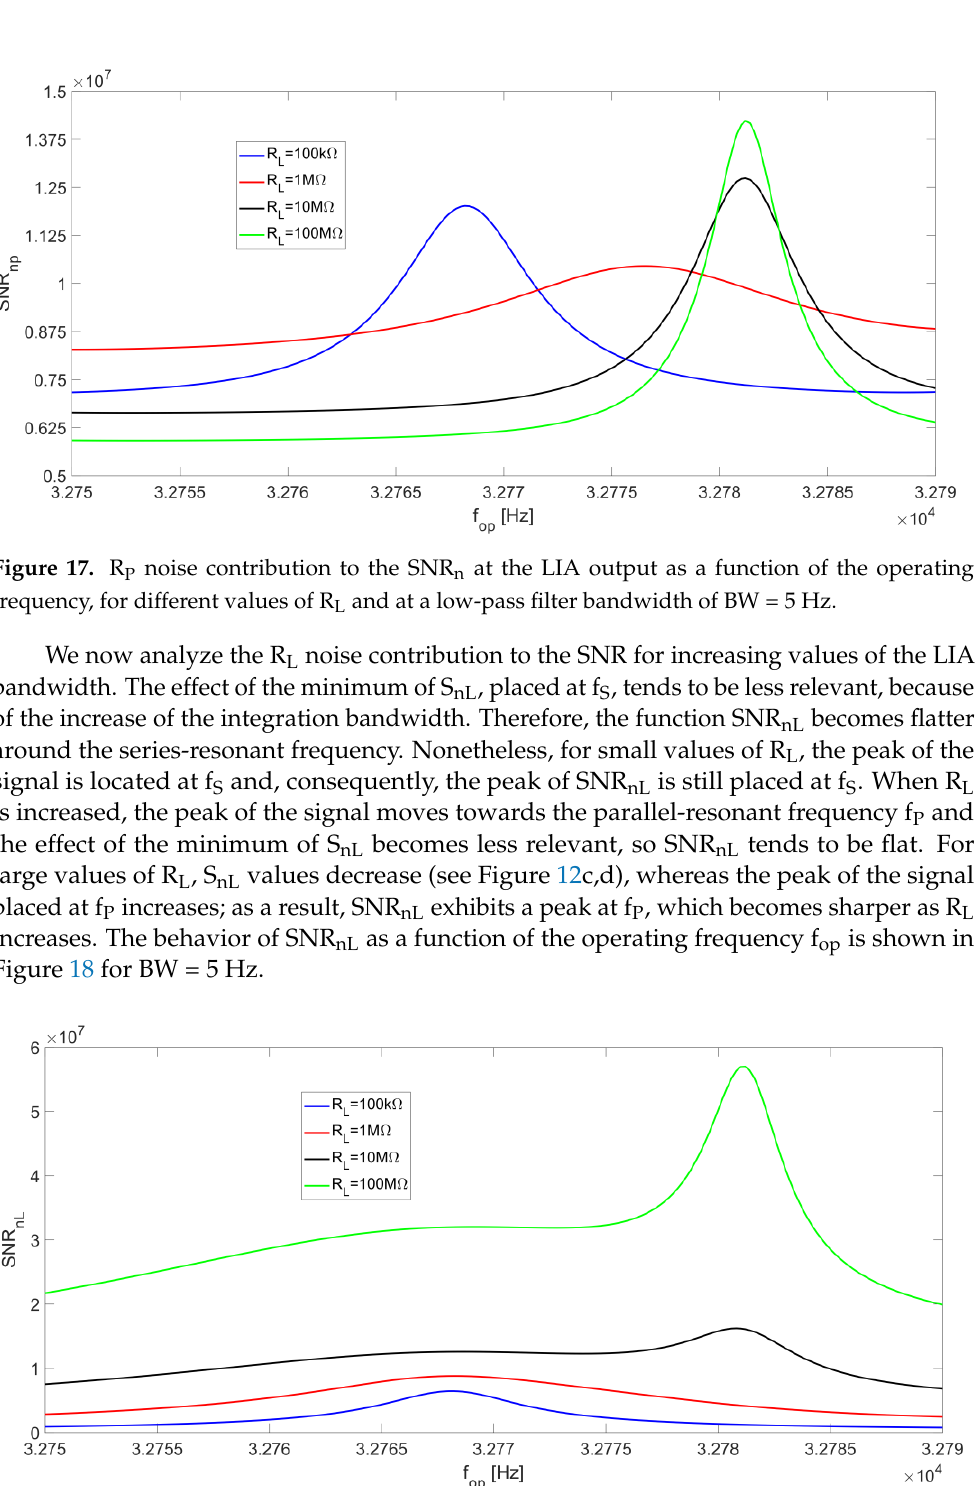
Figure 18. R L noise contribution to the SNR n at the LIA output as a function of the operating frequency, for different values of R L and at a low-pass filter bandwidth of BW = 5 Hz. Finally, from Equation (13), Figure 19 shows that the peak value of SNR n results at f S , where the peak of both SNR np and SNR nL is located, for low values of R L .